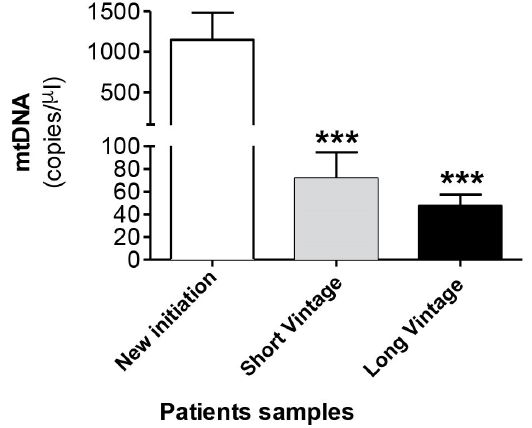
Figure 4. mtDNA levels in the peritoneal effluent from PD patients. Values are the mean ± SEM mtDNA copy numbers of patients classified according to time in PD in new initiation ( n = 49), short vintage ( n = 70) and long vintage ( n = 113) samples. *** p < 0.001 vs. first connection. PD: peritoneal dialysis.